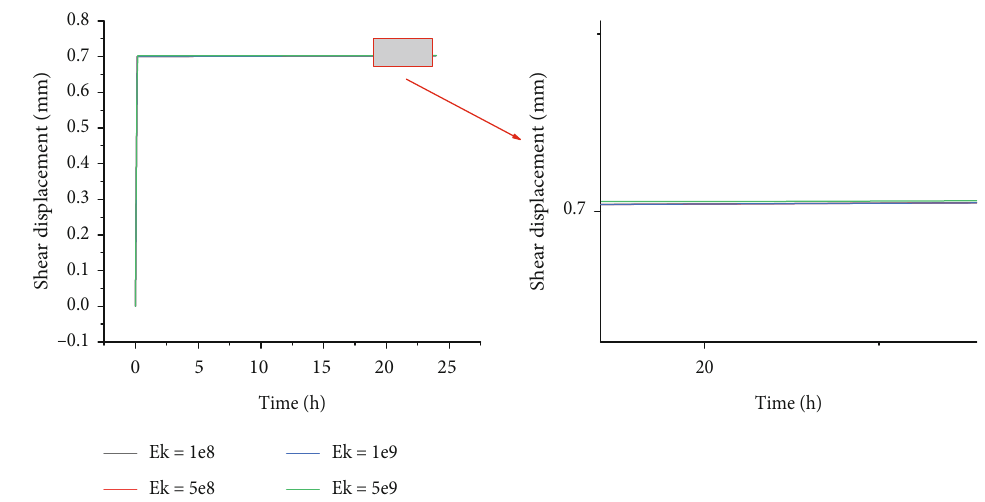
Figure 8: Shear displacement-time curves under di ff erent E